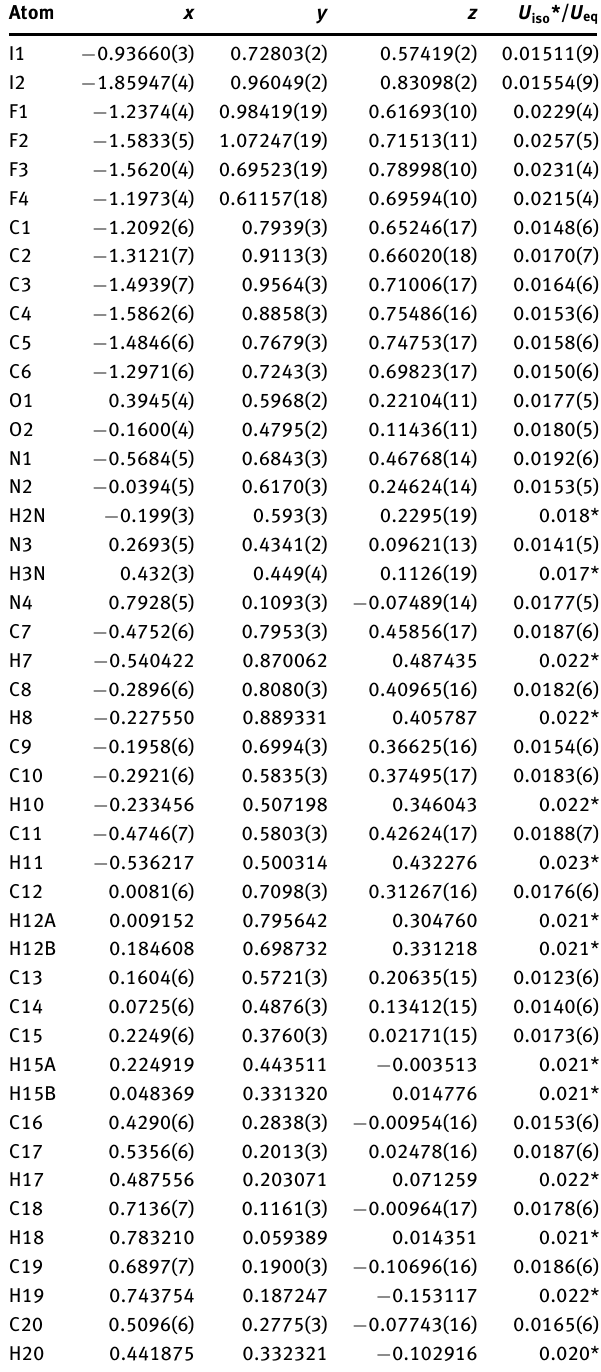
Table 2: Fractional atomic coordinates and isotropic or equivalent isotropic displacement parameters (Å 2